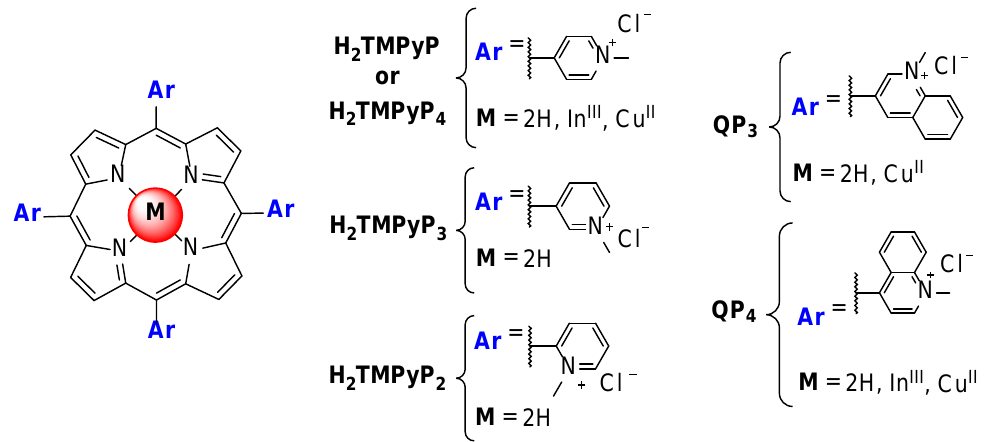
Figure 9. Structure of the first porphyrins and metalloporphyrins evaluated as GQ ligands. The interaction of the complex Cu II TMPyP with tetramolecular GQ with general sequence T 4 G n T 4 , ( n = 4 and 8) was studied by Keating et al. [68] using the spectroscopic methods UV-Vis, fluorescence, CD and electron paramagnetic resonance (EPR). A binding stoichiometric ratio of 2:1 (Cu II TMPyP-GQ) was described and end-stacking of Cu II TMPyP at each end of the G-quadruplex was proposed. Similar behavior has been described for the same porphyrin complex Cu II TMPyP and the T 4 G n T 4 sequence, with n between 4 and 10